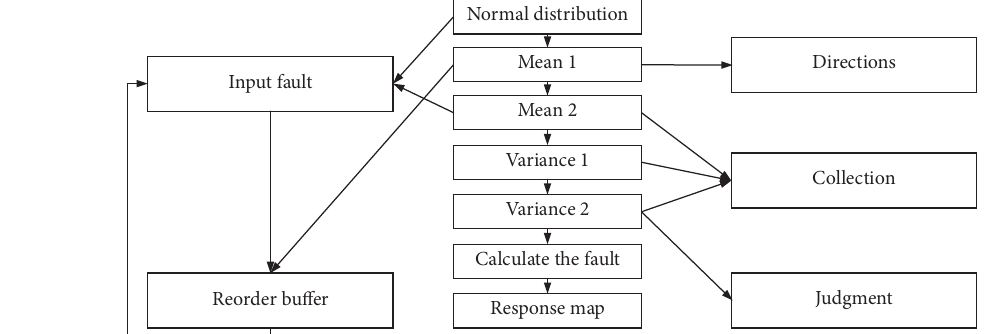
Figure 4: Experimental step design.